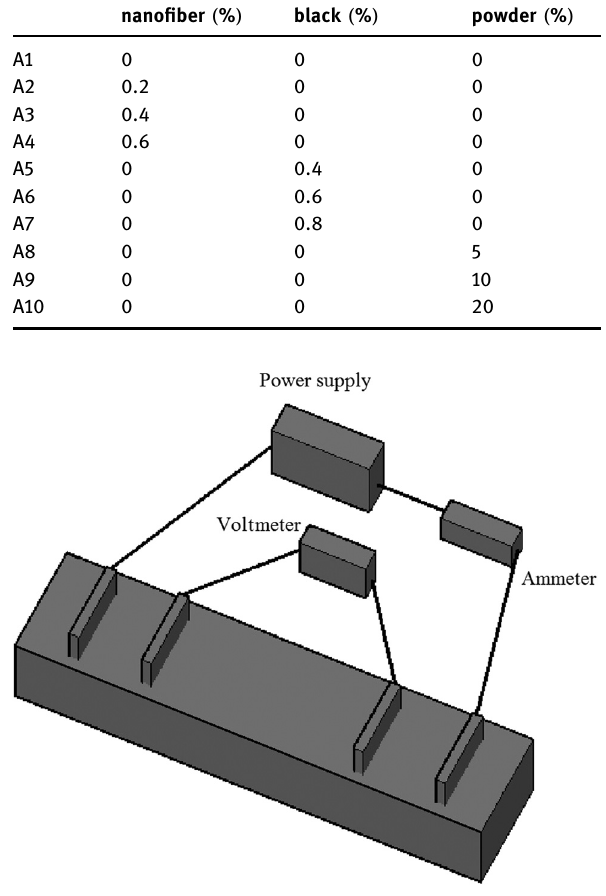
Table 5: Contents of nano and micro conductive materials Mix no.